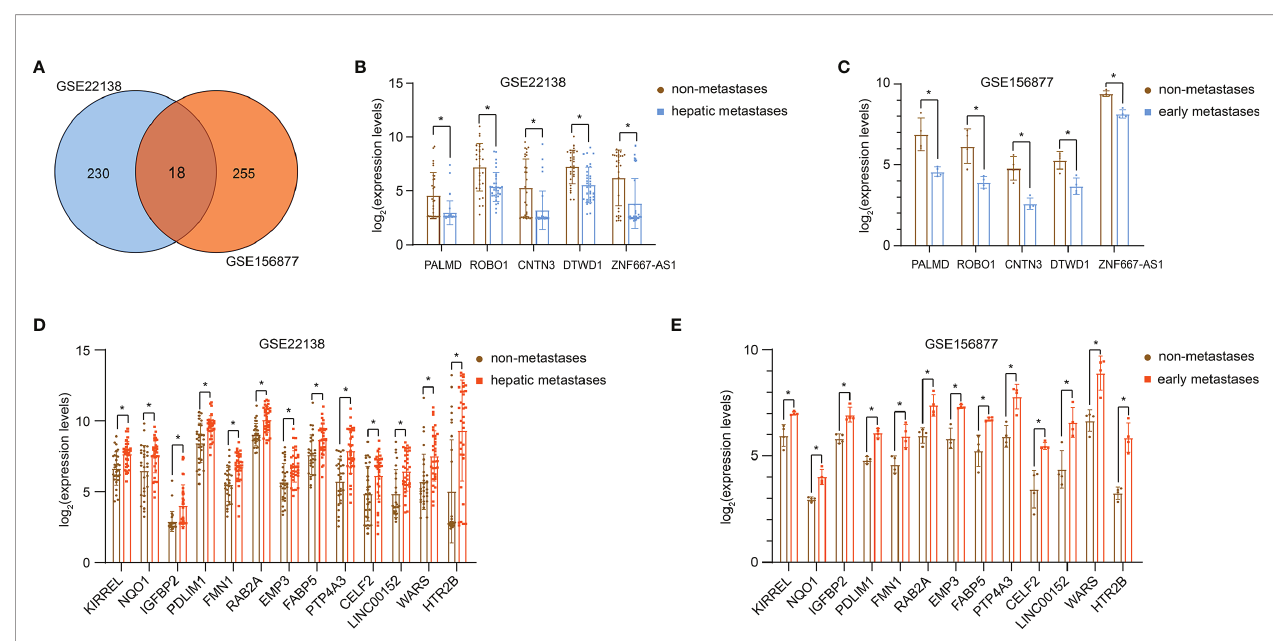
FIGURE 1 | DEGs in UM metastasis. (A) Venn diagram of DEGs from GSE22138 and GSE156877. The expression of 5 genes signi fi cantly down-regulated in GSE22138 (B) and GSE156877 (C) . The expression of 13 genes signi fi cantly up-regulated in GSE22138 (D) and GSE156877 (E) . *P <